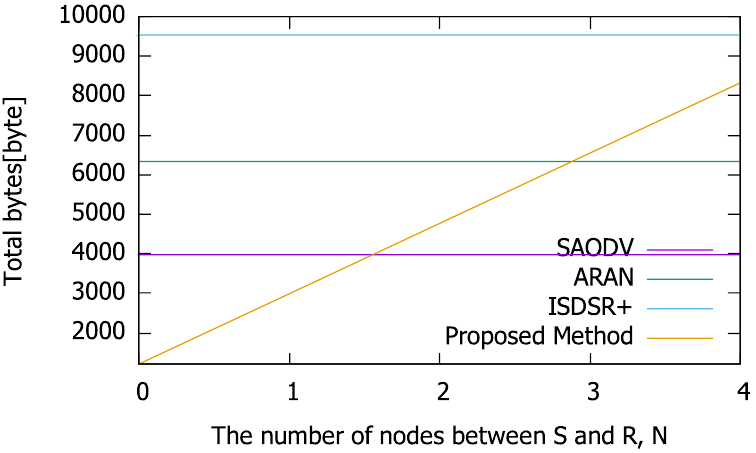
Figure 3. Comparison of the total byte number characteristics with each method at n = 5.